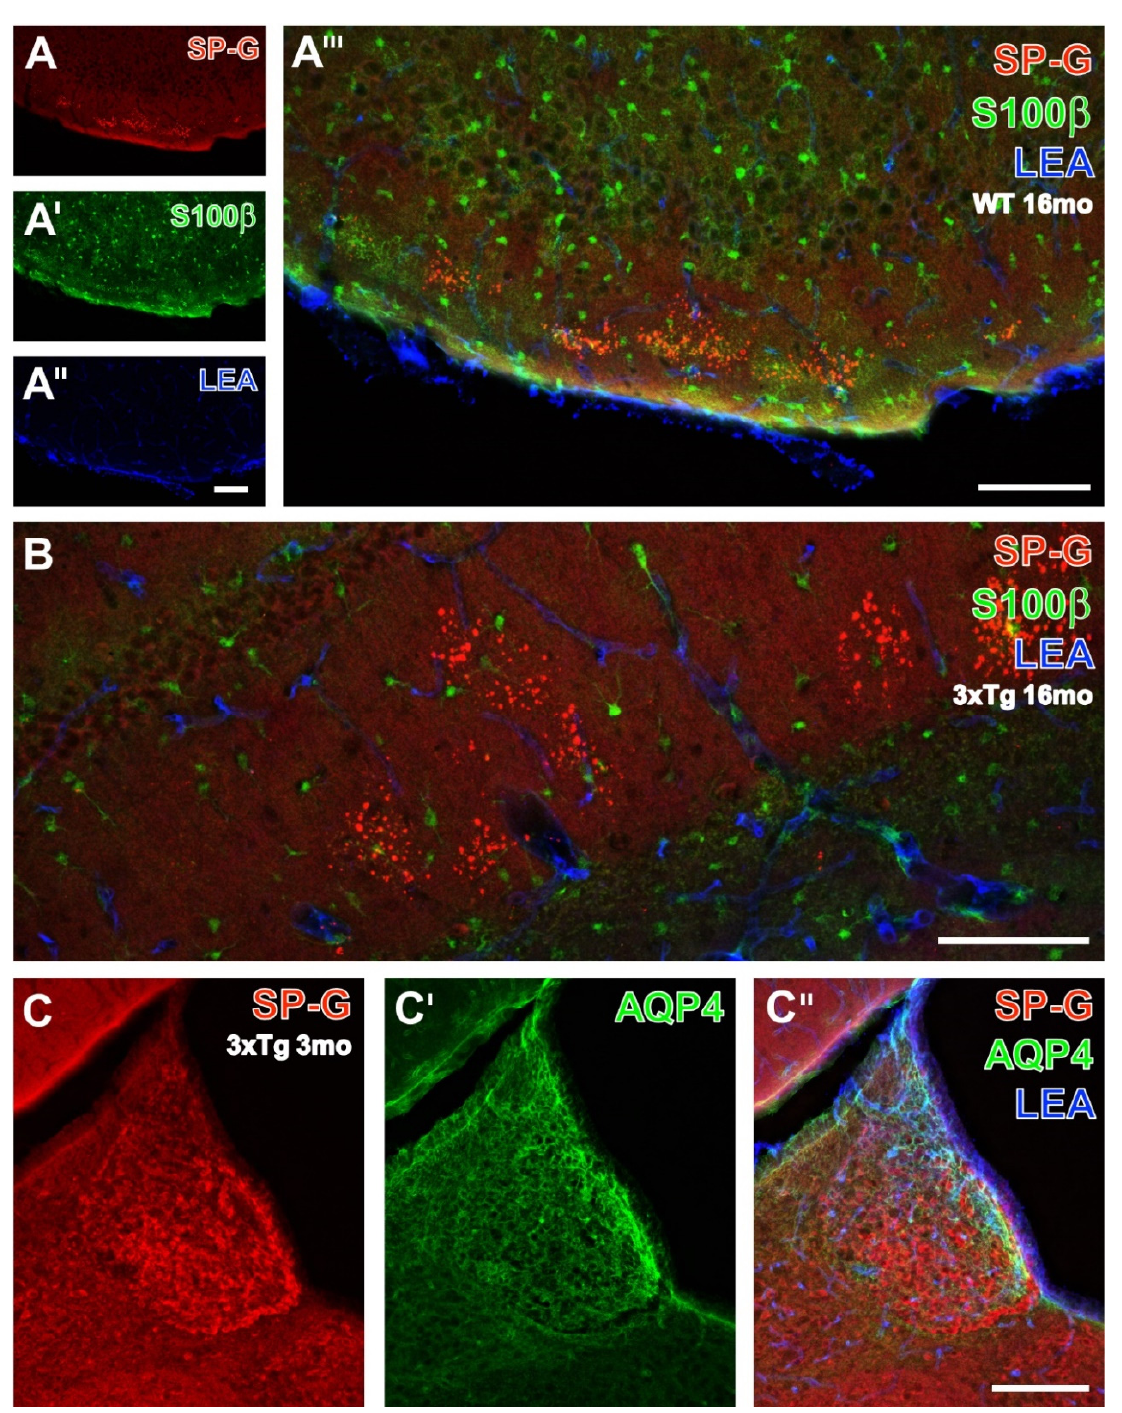
Figure 6. Detection of SP-G-ir and LEA-positive vasculature combined with the immunolabeling of astrocytic S100 β protein of a 16 month-old WT mouse ( A – A’’’ , B ) and aquaporin 4 (AQP4) in the habenula of a 3xTg-AD mouse ( C – C’’’ ). SP-G-ir is concentrated in several clusters of numerous dots in the molecular layer of the piriform cortex ( A ), notably without any cellular immunoreactivity for the surfactant protein and counterstained by evenly distributed, S100 β -containing astroglia ( A’ ) and LEA-stained endothelia ( A’’ ). The complete lack of any mixed color clarifies the lacking co-occurrence of the three markers, which is also found in the hippocampal strata lacunosum-moleculare and radiatum, as well as in the stratum moleculare of the dentate gyrus ( B ) displaying SP-G-containing clusters of dots. In contrast, the habenula of a young 3xTg-AD mouse ( C ) shows numerous immunopositive somata, whereas AQP4-ir becomes visible in some vessels, especially in the outer rim of the medial habenula ( C’ ). The overlay reveals the absent co-expression of SP-G and AQP4, as well as the predominantly vascular association of AQP-4-ir (green) and LEA-binding sites (blue) that results in turquoise-appearing structures. Scale bars: A’’ (also valid for A , A’ ) = 100 µm, A’’’ = 100 µm, B = 100 µm, C’’ (also valid for C , C’ ) = 200 µm.